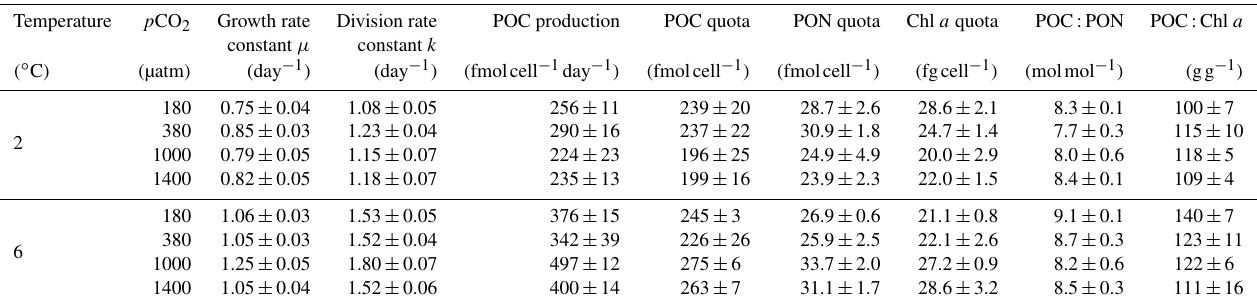
Table 2. Growth rate constants µ , division rate constants k , POC production rates and cellular quota of Chl a , and POC and PON as well as their ratios of M. pusilla at the end of the experiment under the different treatment conditions ( n = 3; mean ± 1SD). Results from statistical analysis can be found in Table